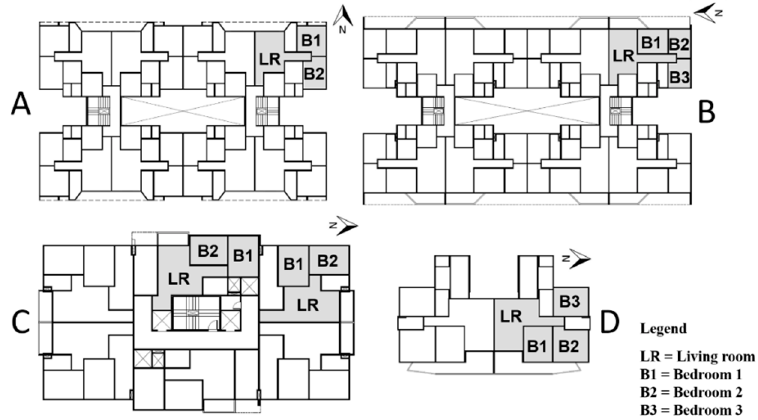
Figure 4. Schematic floor plan of each representative building.